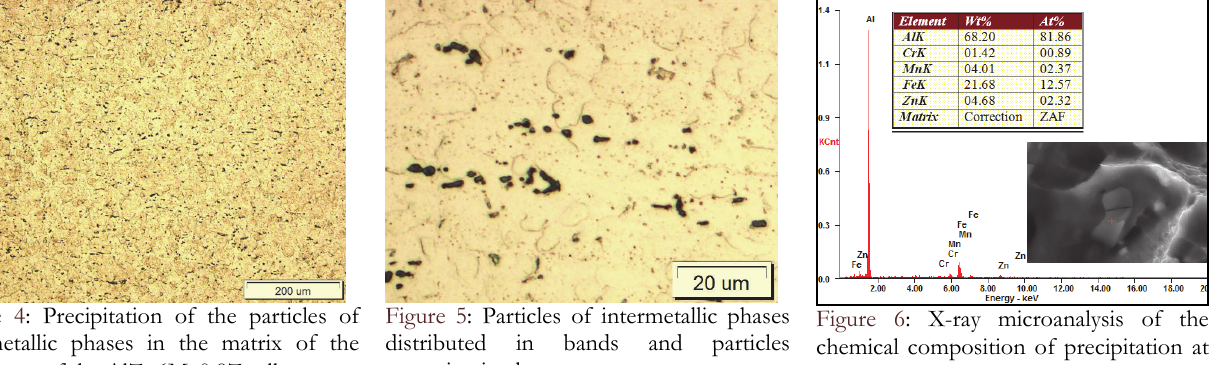
Figure 5: Particles of intermetallic phases distributed in bands and particles occurring in clusters